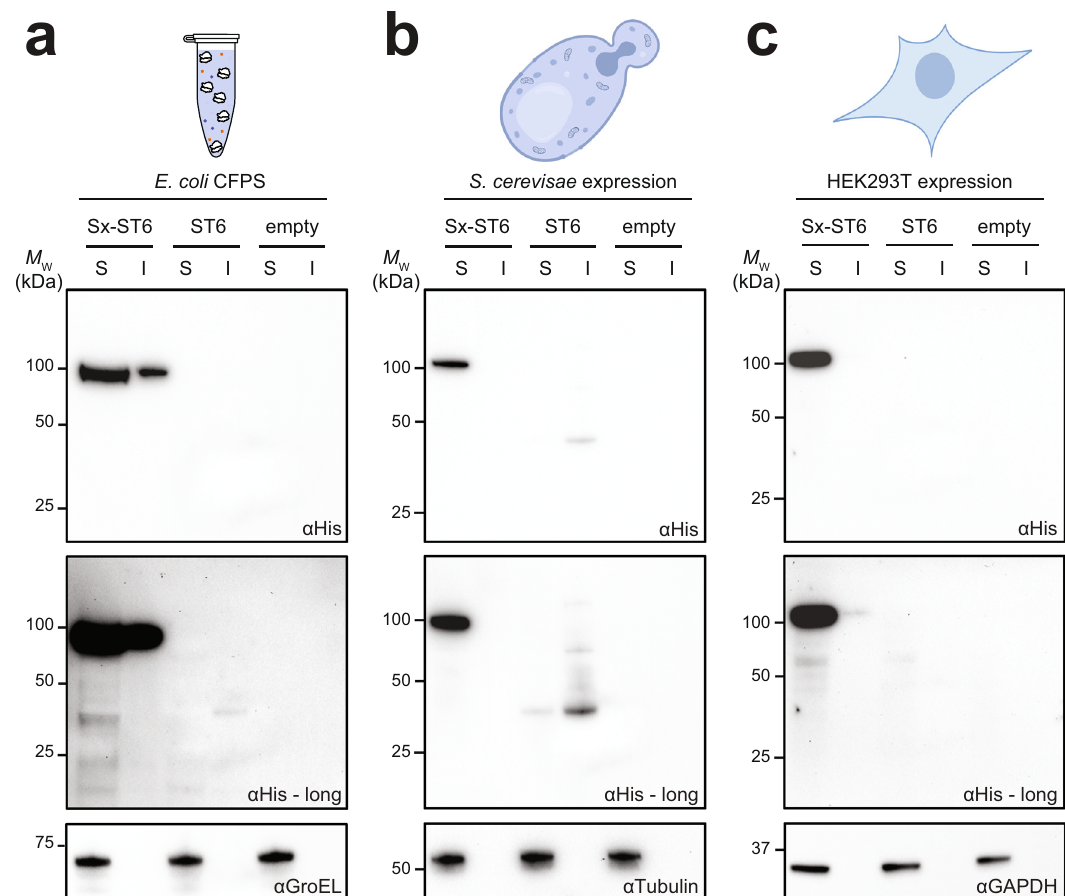
Fig. 3 | Compatibility of SIMPLEx reformatting with diverse expression plat- forms. Immunoblot analysis of the soluble (S) and insoluble (I) fractions derived from a cell-free protein synthesis (CFPS) using crude S30 extract prepared from E. coli BL21(DE3) cells; and cell-based expression using b S. cerevisiae strain SBY49 or c HEK293T cells as indicated. All three systems involved plasmids for expressing either Sx- Δ 26 Hs ST6Gal1 (Sx-ST6) or unfused Δ 26 Hs ST6Gal1 (ST6). Empty plasmid was used as a negative control (empty) in each case. Β lots were probed with anti-